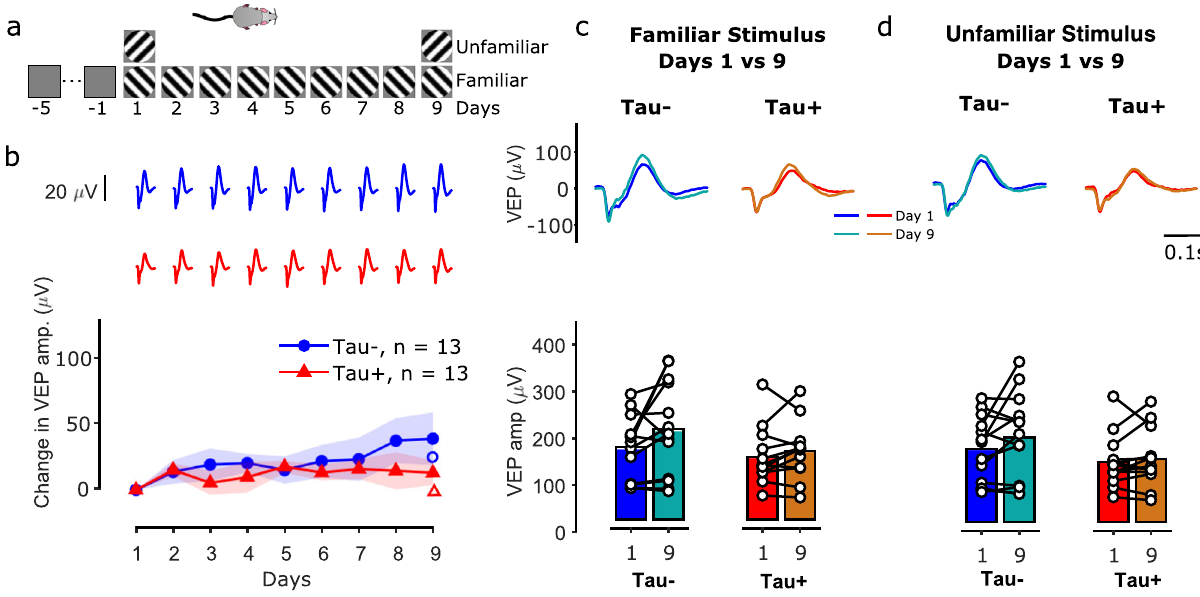
(Fig. 4e, f; Tau − : 15 ± 22, Tau + : 0 ± 24, p < 0.0001).